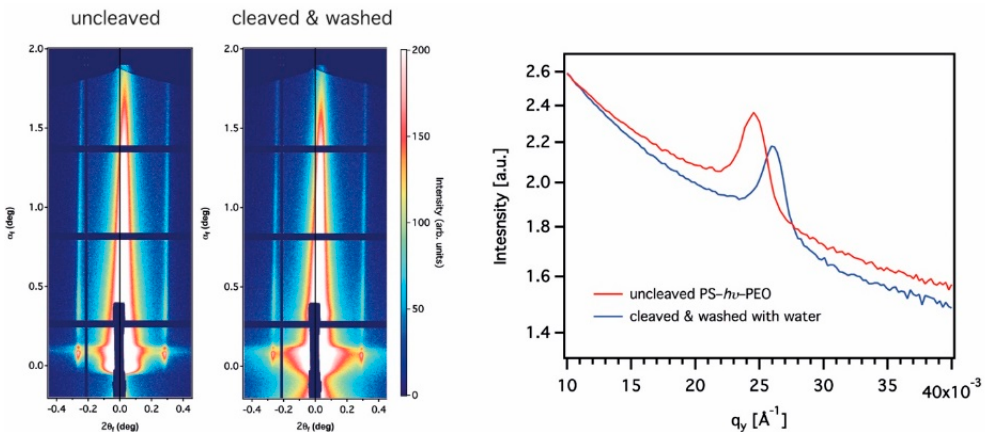
Figure 10. Two-dimensional grazing incidence small-angle X-ray scattering (2D GISAXS) scattering image of PS- h ν -PEO block copolymer thin film before and after UV cleavage (4 h)/washing with ultra-pure water (50 min.); the high intense symmetric peaks are the first-order diffraction Bragg peaks. Where the plot on the right side is a one-dimensional (1D) out-of-plane profile of the 2D scattering image along the direction of the wavevector q y , including both peaks before and after washing with ultra-pure water.